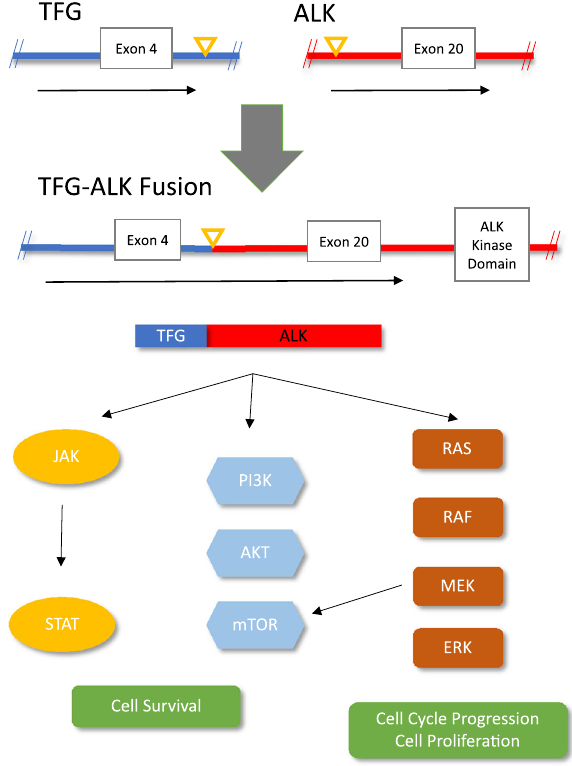
Fig. 3 TFG-ALK fusion and downstream pathway activation. TFG- ALK fusion product is displayed as a t(3;2) fusion at exon 4 of TFG (blue) and exon 20 of ALK (red). The point of the fusion is indicated by the yellow triangle. The druggable ALK kinase domain resides downstream of ALK exon 20. The upregulated ALK pathway by means of fusion product is implicated in many oncogenic cellular pathways including JAK/STAT, PI3K/mTOR, and